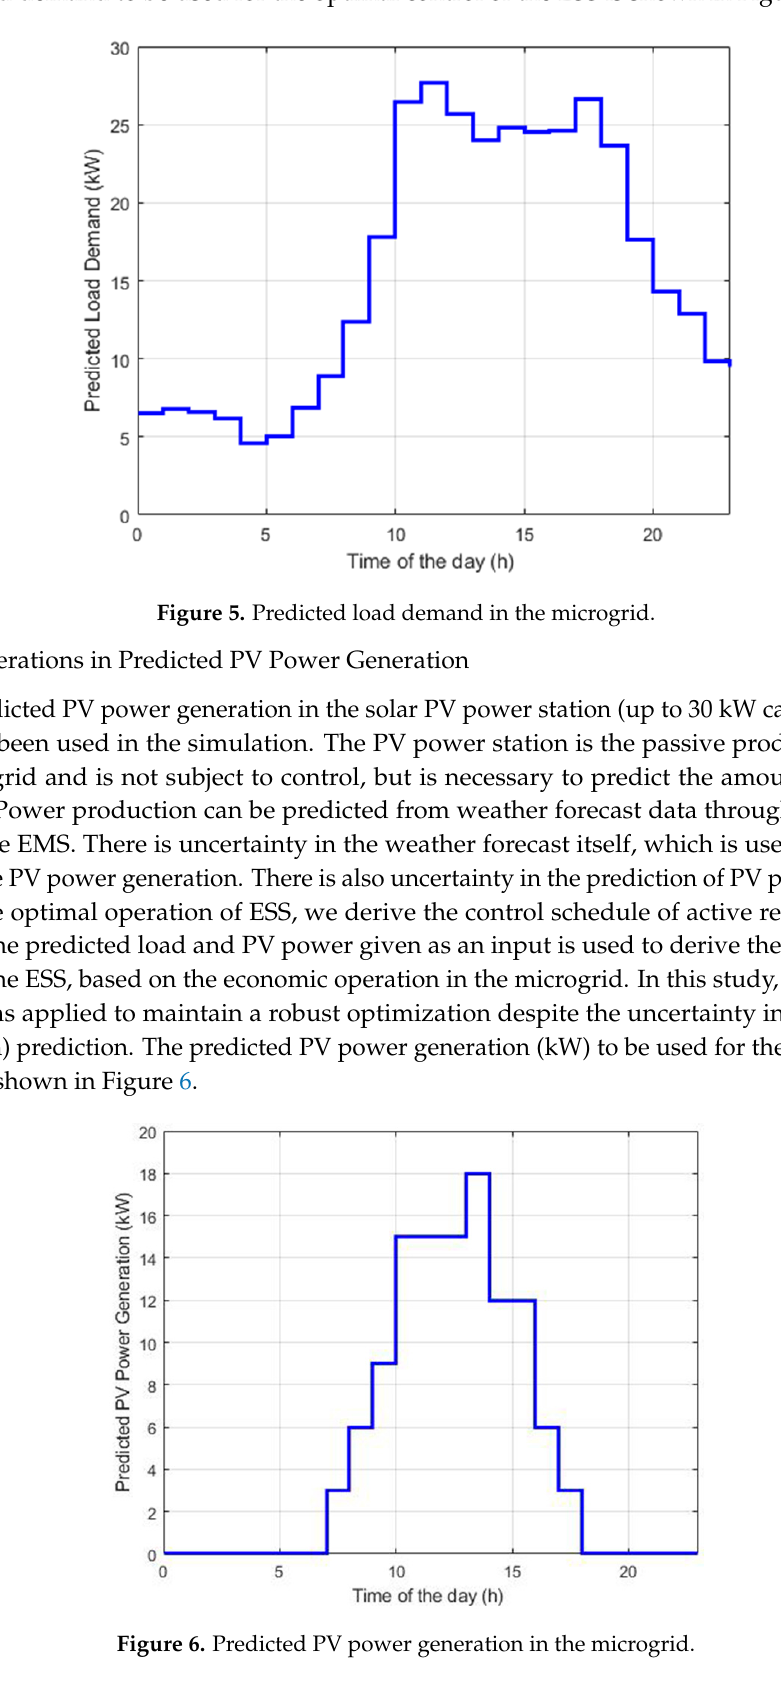
Figure 6. Predicted PV power generation in the microgrid.